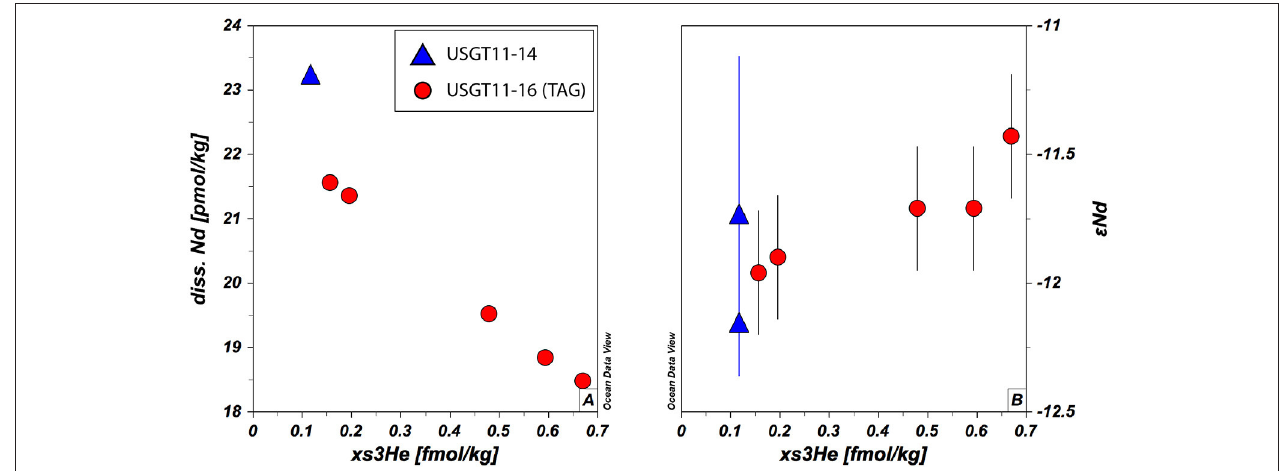
FIGURE 4 | Comparison of xs 3 He and Nd (A) and Nd isotopic composition (B) at stations USGT11-14 and TAG between 3,184 and 3,605m. The figure is designed with ODV ® software ( Schlitzer, 2016a).